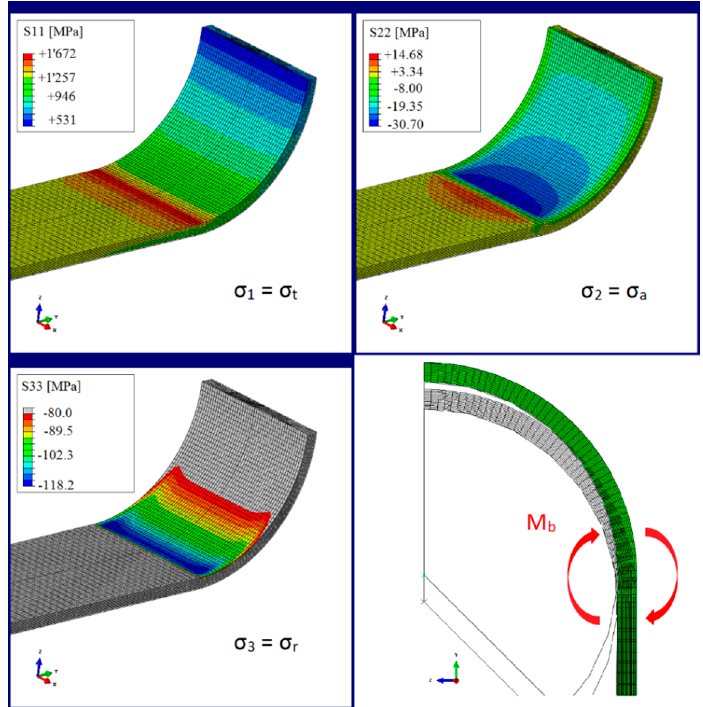
Figure 10. Stress distribution in the vertex area of a 12 mm wide and 1 mm thick strap in contact with an analytical rigid pin ( cof = 0.5). an analytical rigid pin ( cof =